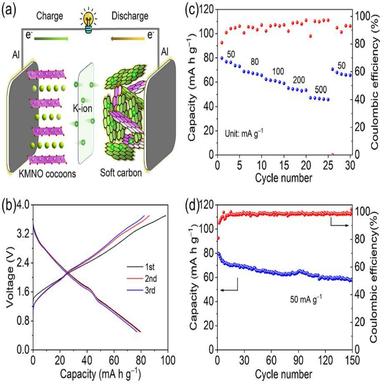
(a) Schematic illustration, (b) selected charge/discharge profiles at 100 mA g1 , (c) rate property, and (d) cyclic performance of the KMNO cocoons//pitch-derived soft carbon K-ion full cells.